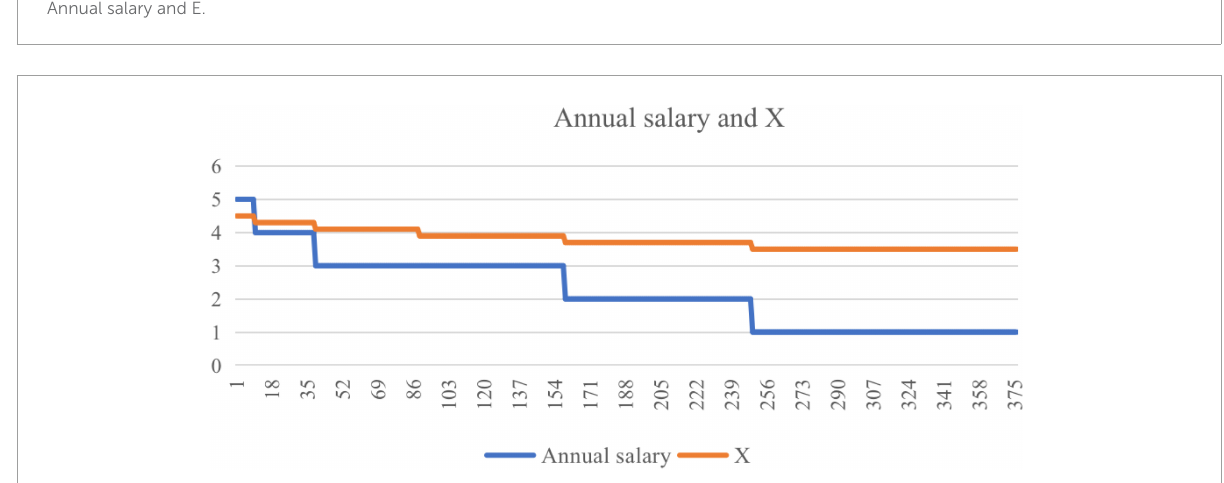
FIGURE3 Annual salary and